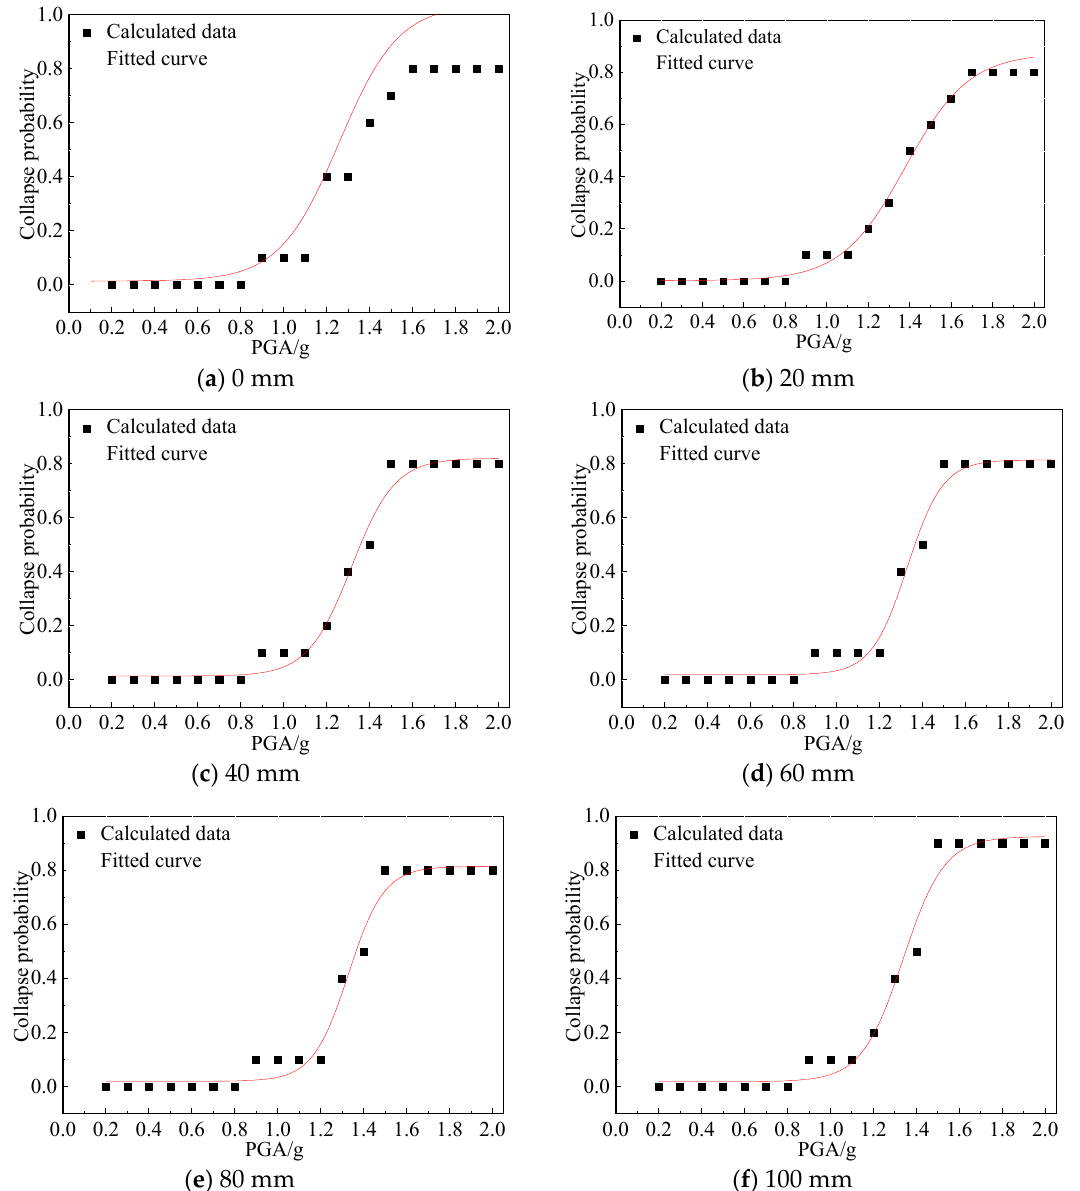
Figure 8. Collapse probabilities of structures with different uneven settlement quantities in Zone III.